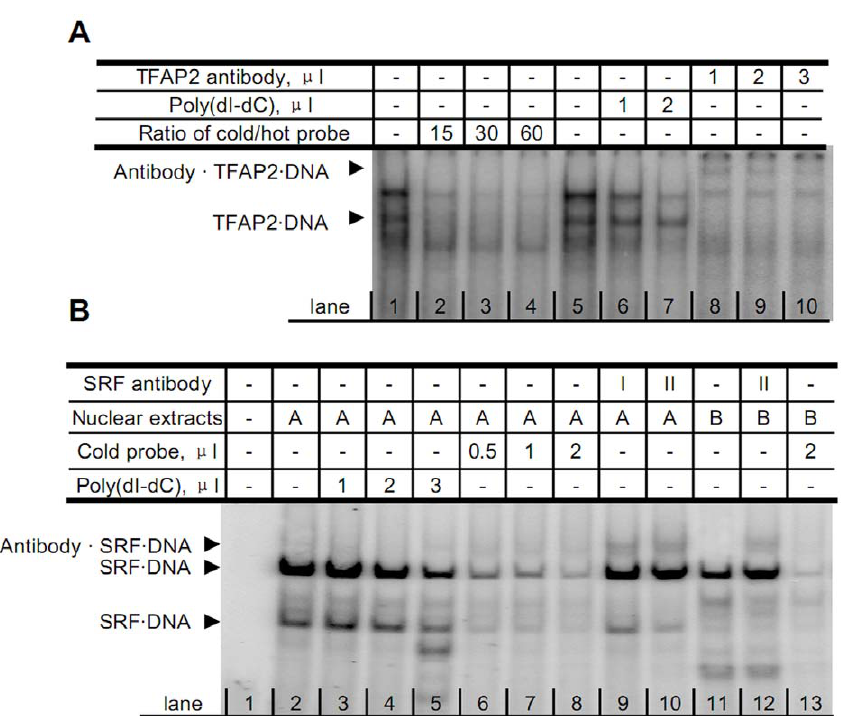
Figure 2. Transcription factors SRF and TFAP2 bind to the FXN promoter region invitro . EMSA analysis was performed to investigate binding of TFAP2 (A) and SRF (B) to the promoter region of FXN in vitro . Nuclear extracts from HEK293 cells were incubated with [ c - 32 P]-ATP labeled oligonucleotides coding the predicted TFAP2 or SRF binding site on the FXN promoter region of interest for 1 hour at 4 u C. The binding products were resolved in native polyacrylamide gels (see MATERIALS AND METHODS). Specific competitor (non-radioactive oligonucleotide, so called cold probe, 10 m M) or non-specific competitor (poly(dI-dC), 0.5 mU/ m L) was added to assess the specificity of the binding of SRF or TFAP2. Antibodies of TFAP2 (2 mg/ml) and SRF (0.5 mg/ml) were added for supershift, respectively. I: SRF antibody purchased from Santa Cruz Biotech.; II: SRF antibody purchased from Active Motif. A: HEK293 cell nuclear extracts, prepared by the authors, B: Jurkat cell nuclear extracts, purchased from Active Motif (Carlsbad, CA).